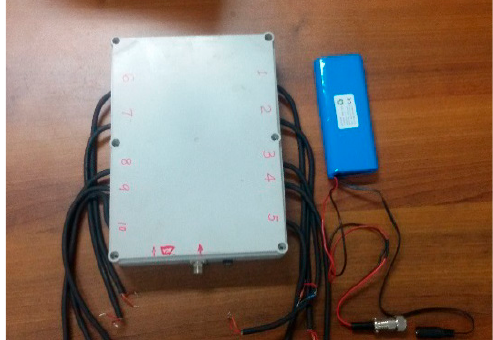
Figure 14. A system of offline collection of dynamic signals.